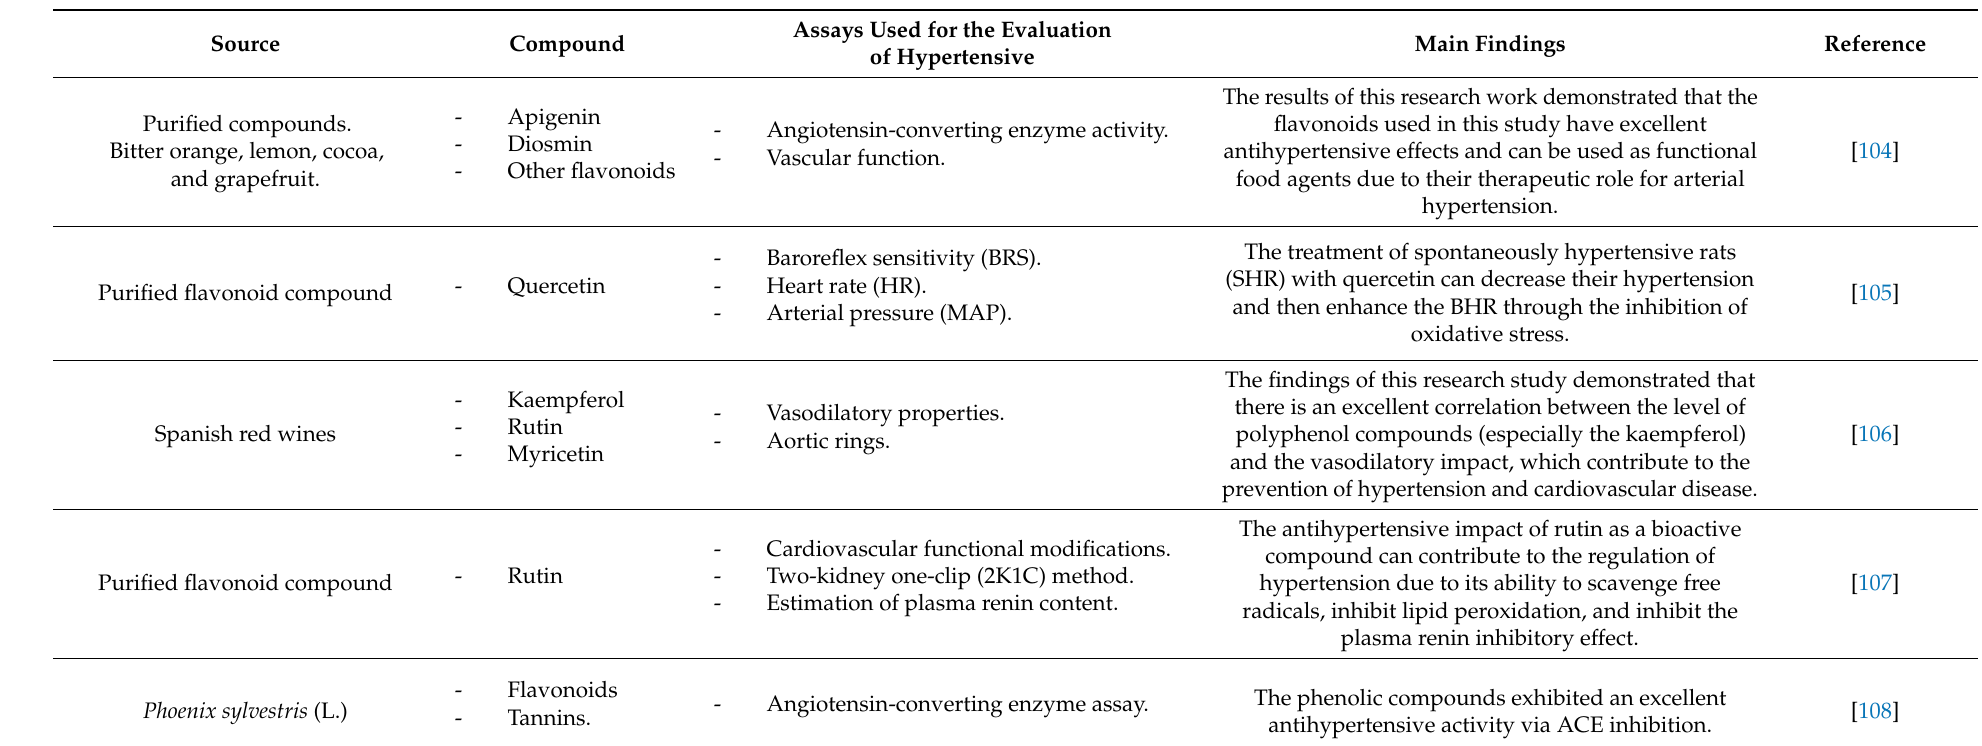
Table 3. The antihypertensive properties of some phenolic compounds.